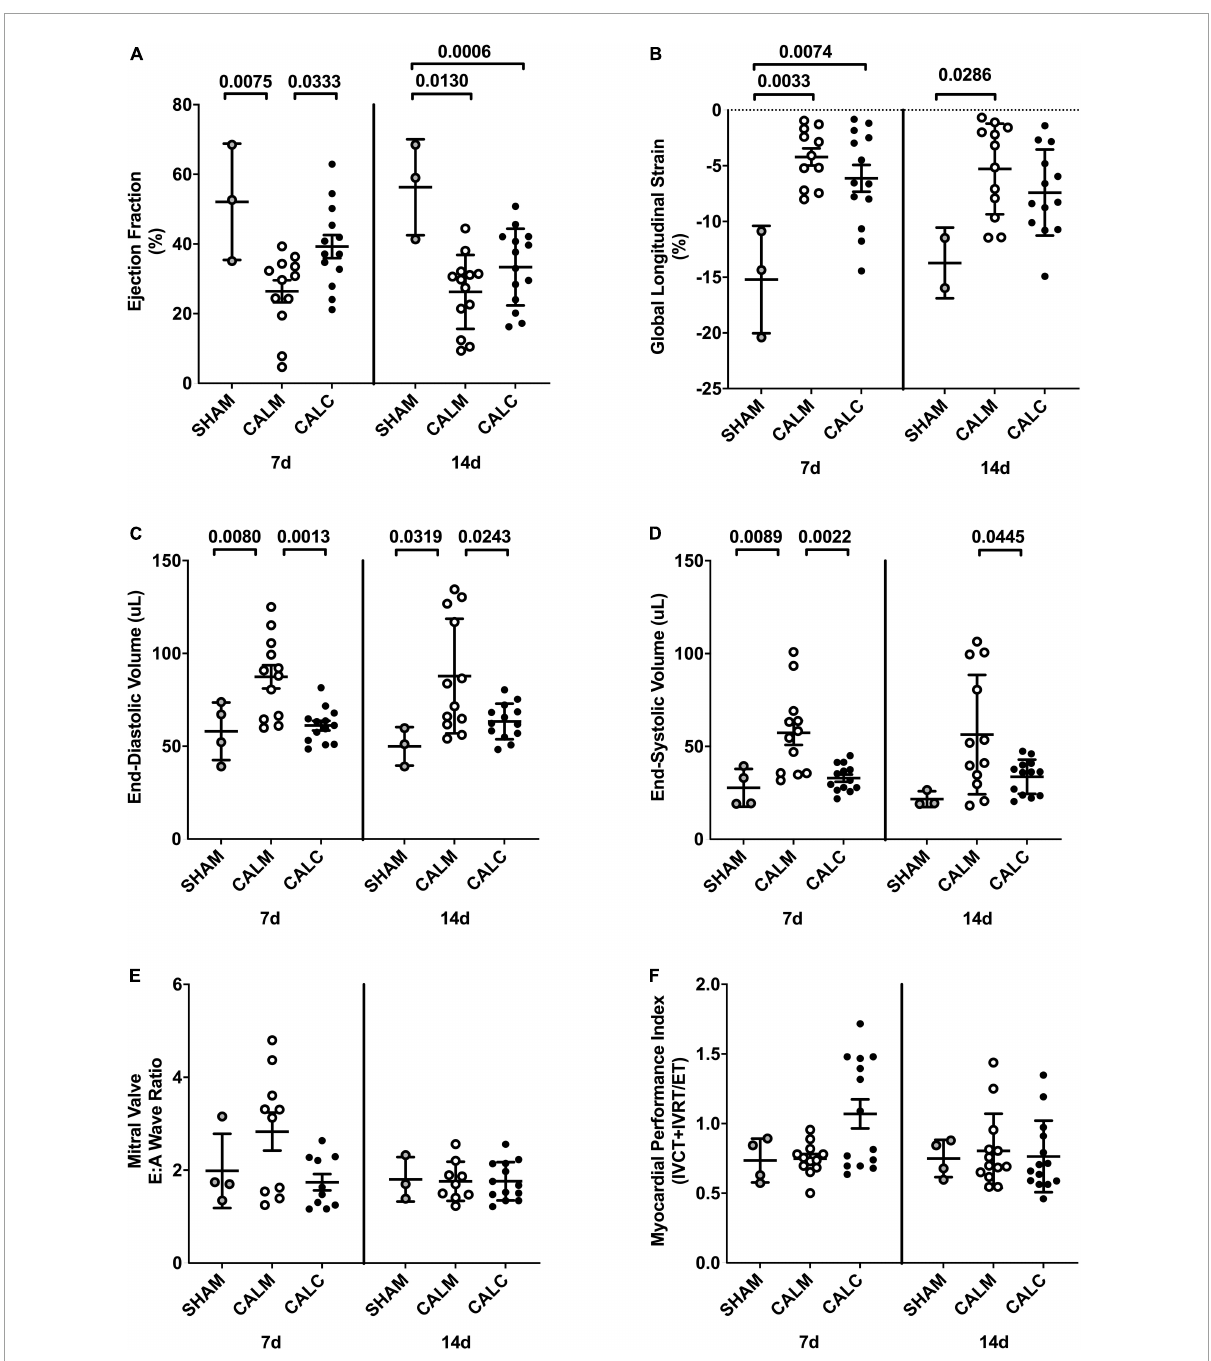
FIGURE4 Echocardiography outcomes in hESC-ECP and media injected mice. Ejection fraction (A) was preserved in CALC mice compared to CALM at 7 d, but not at 14 d post-injection. Global longitudinal strain (B) was increased at 7 d in both CALC and CALM compared with SHAM, but only in CALM mice at 14 d. End-diastolic volume, EDV (C) , and end-systolic volume, ESV (D) , were preserved at 7 and 14 d in CALC compared with CALM mice. Mitral valve E/A wave ratio (E) and myocardial performance index (F) were not different amongst groups at either time point. ANOVA with Tukey’s post-hoc test. Data are mean ±